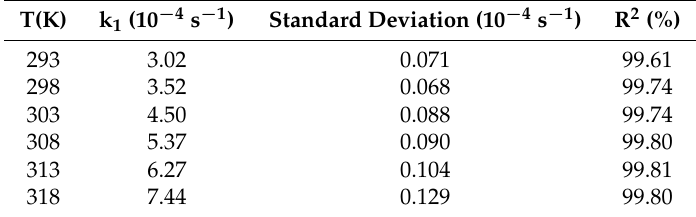
Table 3. The key parameters of the fitted curves with different temperatures.